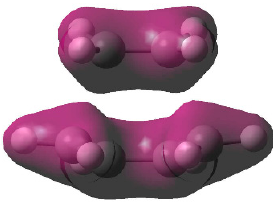
Figure 1. B3LYP/6-31G(d) map of the total electron density of the transition state structure TS1 associated with the DA reaction between butadiene 1 and ethylene 2 . Isovalues of the map of the electron density are 0.08.